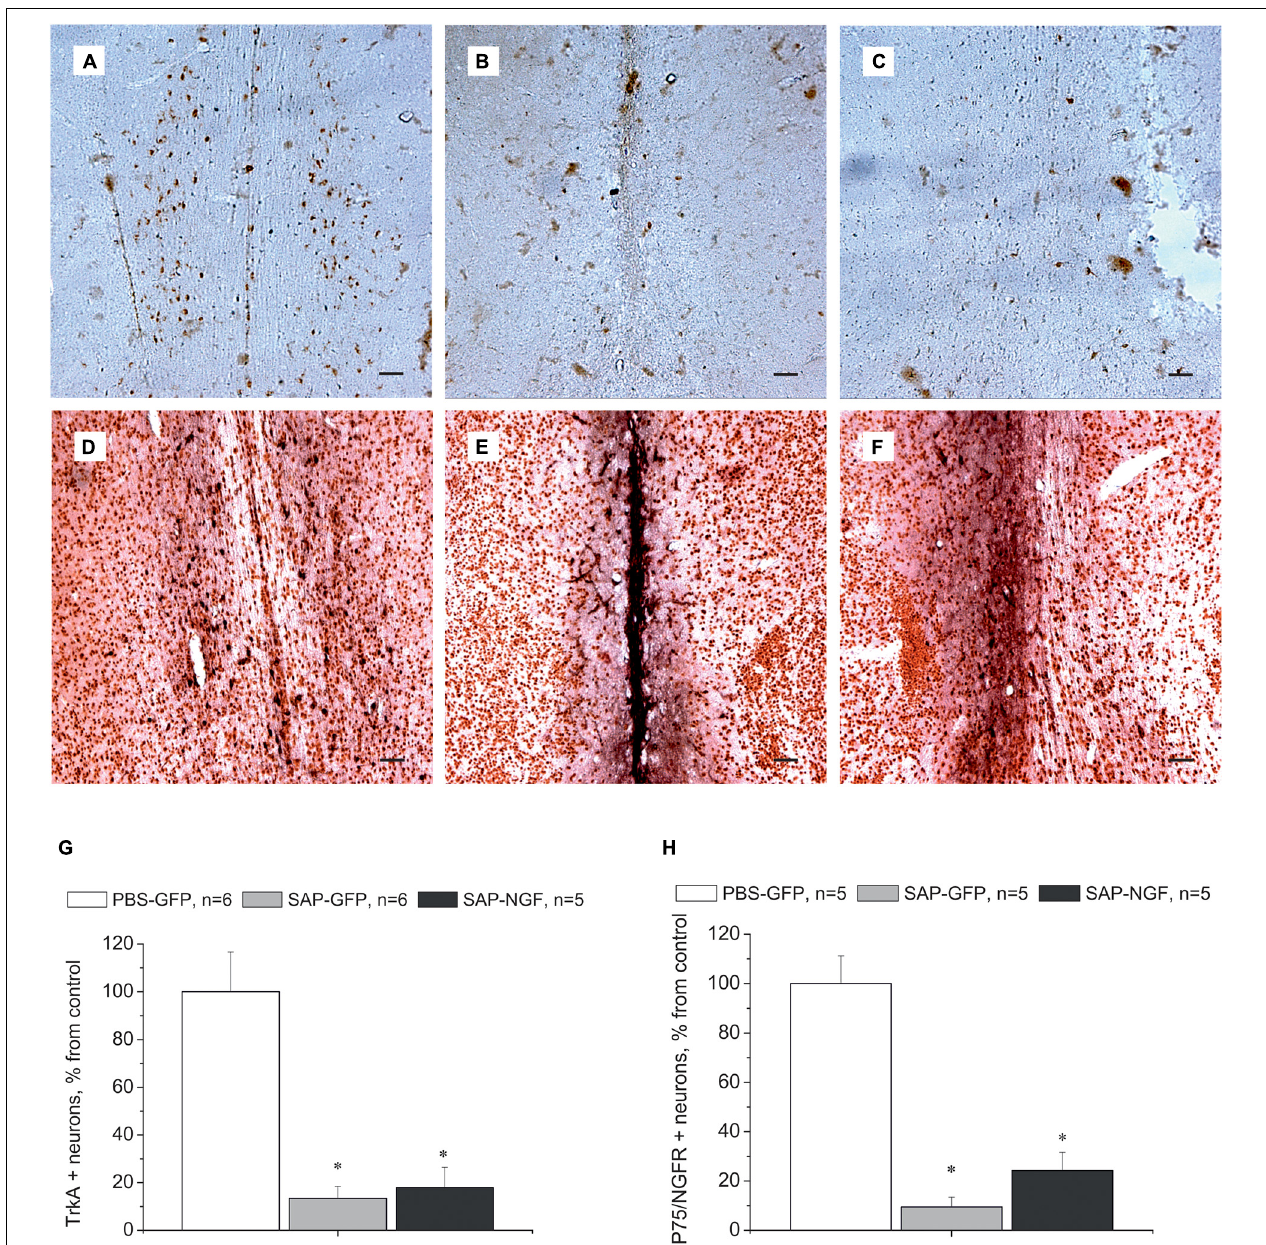
FIGURE 4 | (A–C) Show medial septum regions from rats of the control group (A) , 192IgG-saporin–treated group (B) , and group treated with 192IgG-saporin and NGF-carrying virus (SAP-NGF) (C) stained with antibodies against TrkA. (D–F) Represent medial septum sections from PBS-treated (D) , 192IgG-saporin–treated, (E) and 192IgG-saporin–treated NGF-overexpressing rats (F) stained with antibodies against NeuN (brown) and p75/NGFR (black). (G) Shows the number of TrkA-positive neurons in the medial septum area. (H) Shows the number of p75/NGFR-positive neurons in the medial septum area. Bar is 400 µ m. *Significant differences against the PBS-GFP group, p <